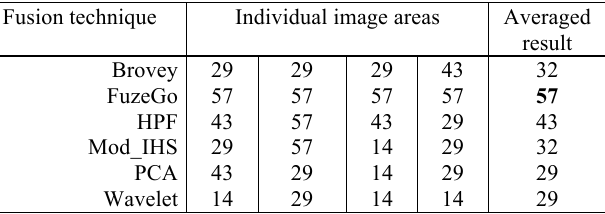
Table 4. Visual assessment of the criterium artefacts at local level. The maximum score reachable is 57 (Fries 2017).